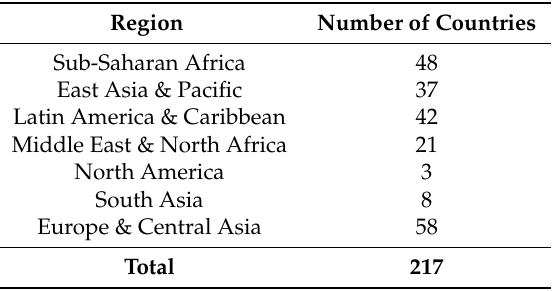
Table 1. Regional breakdown of the analyzed data [22].